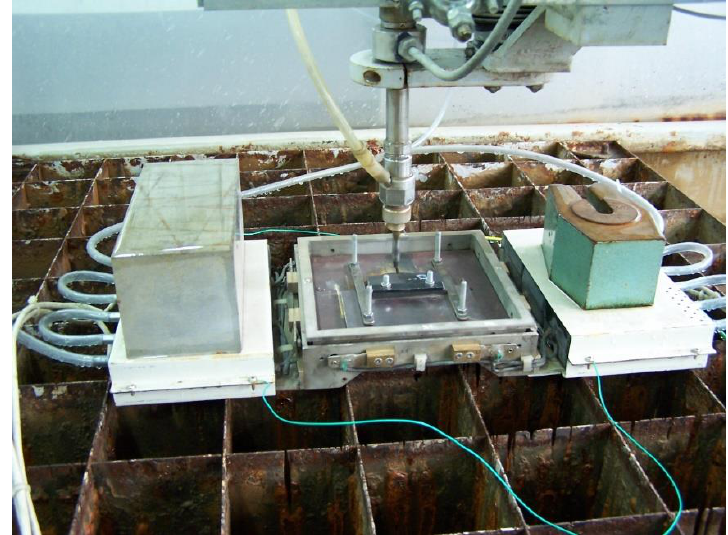
Figure 4. Force sensor on the cutting table in Kielce.